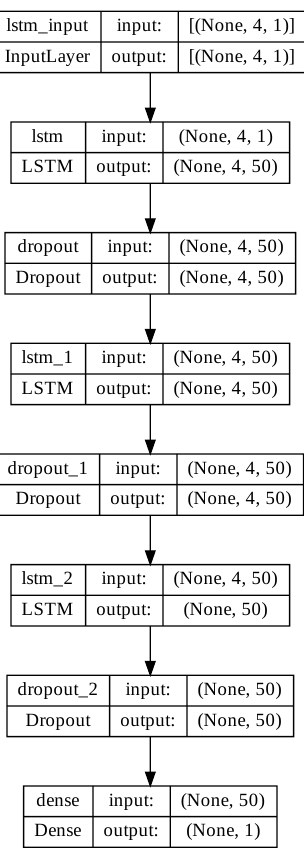
The binary cross entropy error is the average of the sum of the product of the expected value and the logarithm of the result of a given trial and the product of the difference between one and the expected value and the logarithm of the difference between one and the result of a given trial